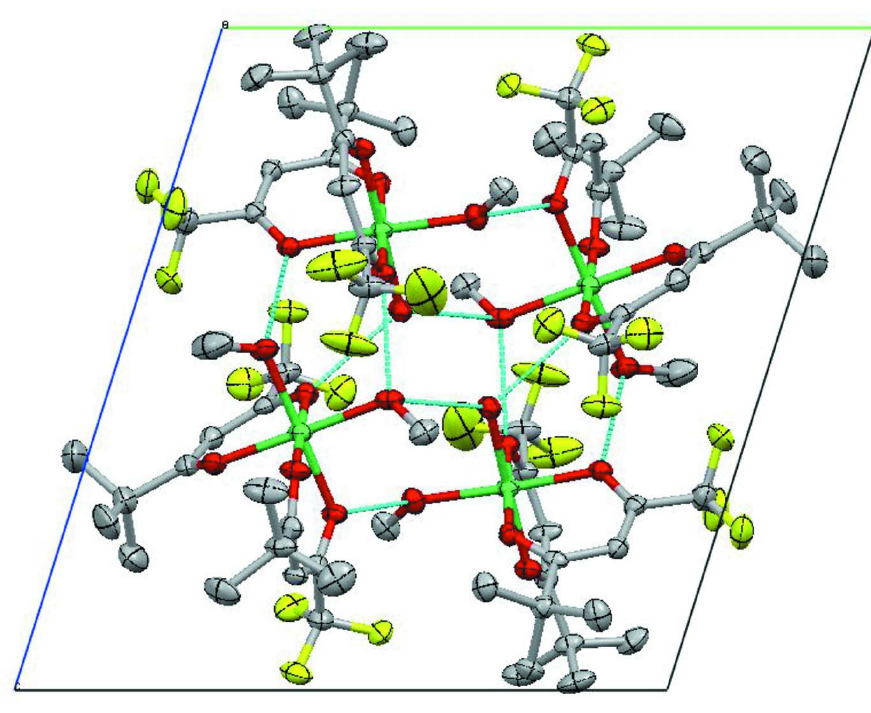
Figure 2 Packing view of the title compound along the [100]. Hydrogen bonds are indicated as dashed lines. Minor moieties of disordered moieties and hydrogen atoms are omitted for